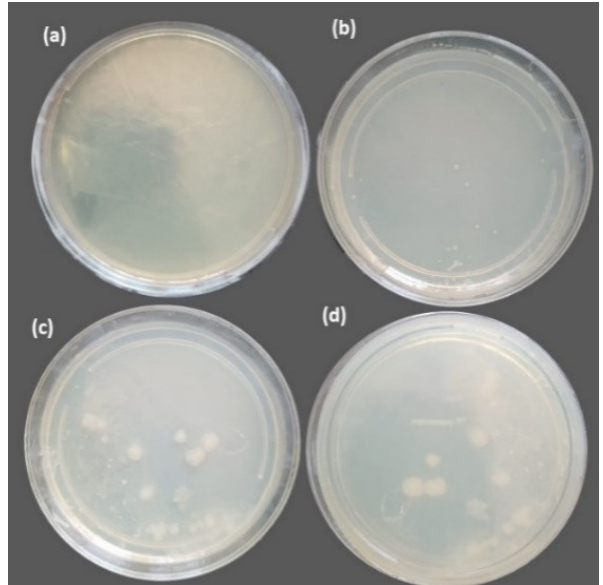
Figure 4. Photographs of E.coli colonies on an agar plate after photocatalytic bactericidal treatment with Ag 9 (SiO 4 ) 2 NO 3 for ( a ) 10 min, ( b ) 8 min, ( c ) 6 min, and ( d ) 4 min.